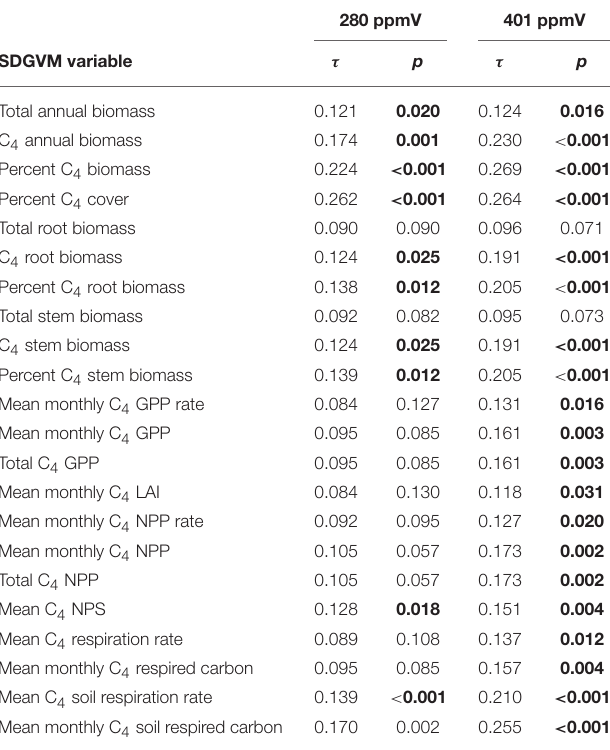
TABLE 3 | Kendall’s rank correlation coefficients ( τ ) and p -values for comparisons of estimates of mean percent C 4 biomass from δ 13 C-values of Miocene biominerals with results of two cases of the